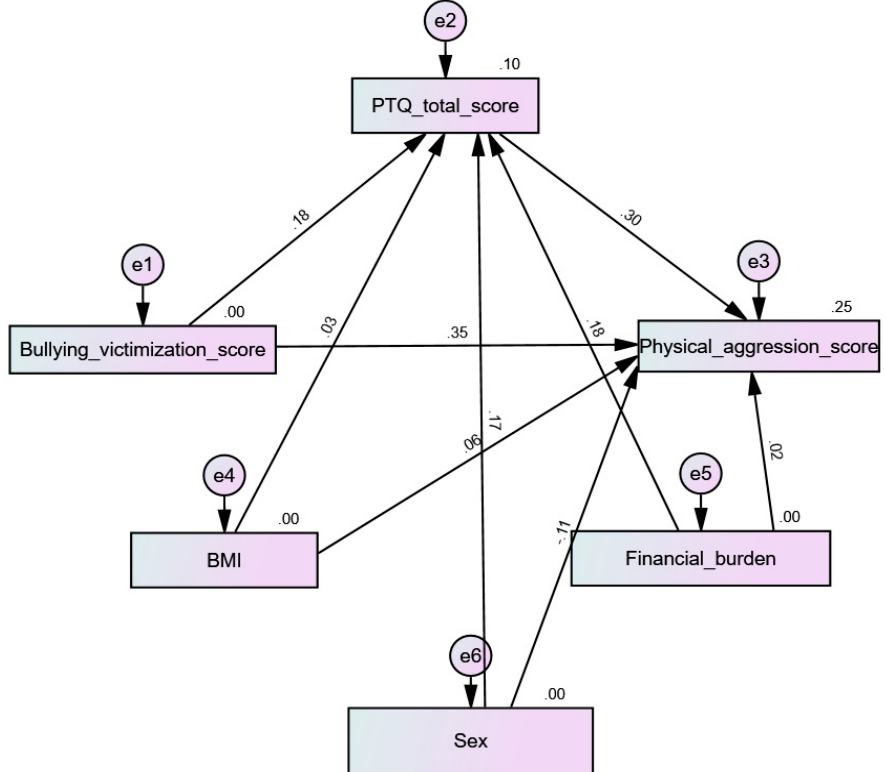
Children 2023 , 10 , x FOR PEER REVIEW